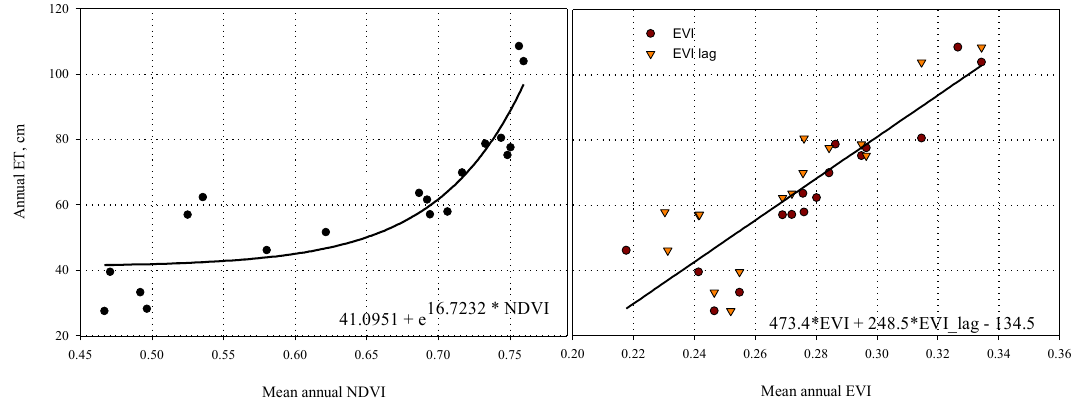
Figure 2. Mean annual Normalized Difference Vegetation Index (NDVI) ( R 2 = 0.81, p < 0.0001) and Enhanced Vegetation Index (EVI) ( R 2 = 0.86, p < 0.001) regressions with mean annual ET. The equation represents the best ‐ fit line. The EVI includes a one year lagged term to account for water storage effects carried over from the current year, which resulted in a better fit than only using same year EVI data. The NDVI had a better relationship without the lagged values.